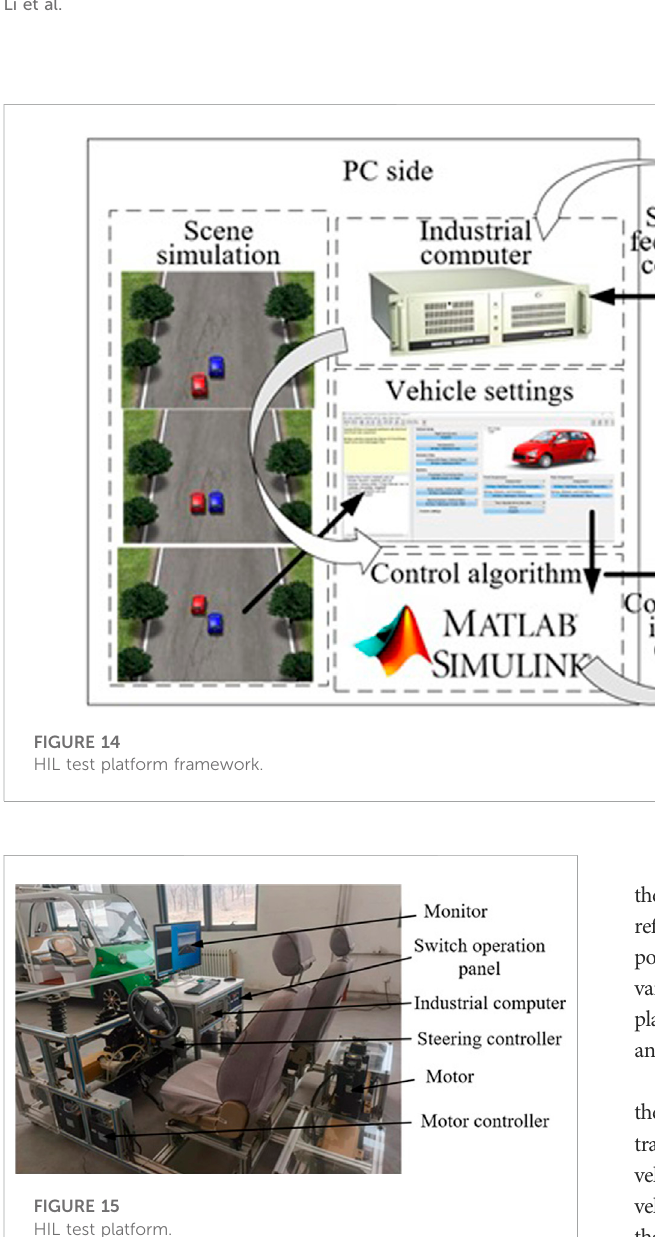
FIGURE 15 HIL test